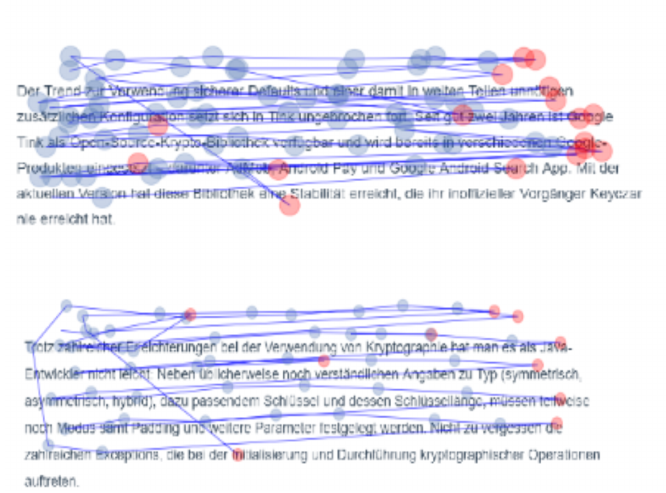
Figure 2. Eye movements during the reading task (fixation points in blue and regression points in red). Top : Paragraph with reported mind wandering, bottom : paragraph with focused reading